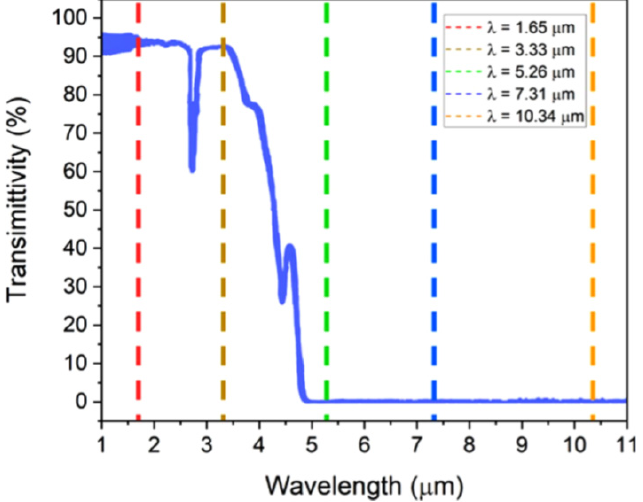
Figure 11. Continuous line: transmittance spectrum of the QTF quartz measured using a Fourier transform spectrometer. Dashed lines: the central wavelengths of the used lasers in this work. Reprinted/adapted with permission from Ref. [70]. Copyright 2021, copyright AIP Publishing.